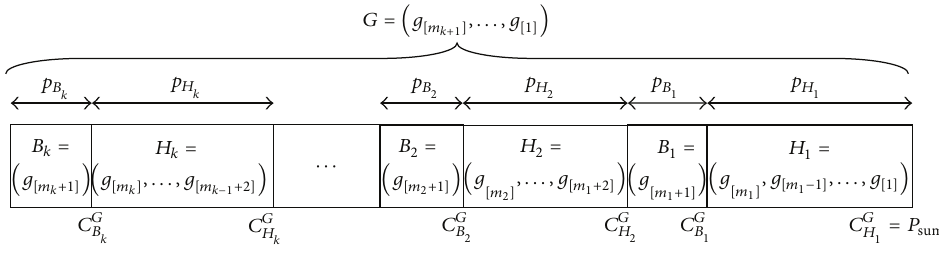
Figure 4: Sequence of tardy jobs in Case 1 after sorting